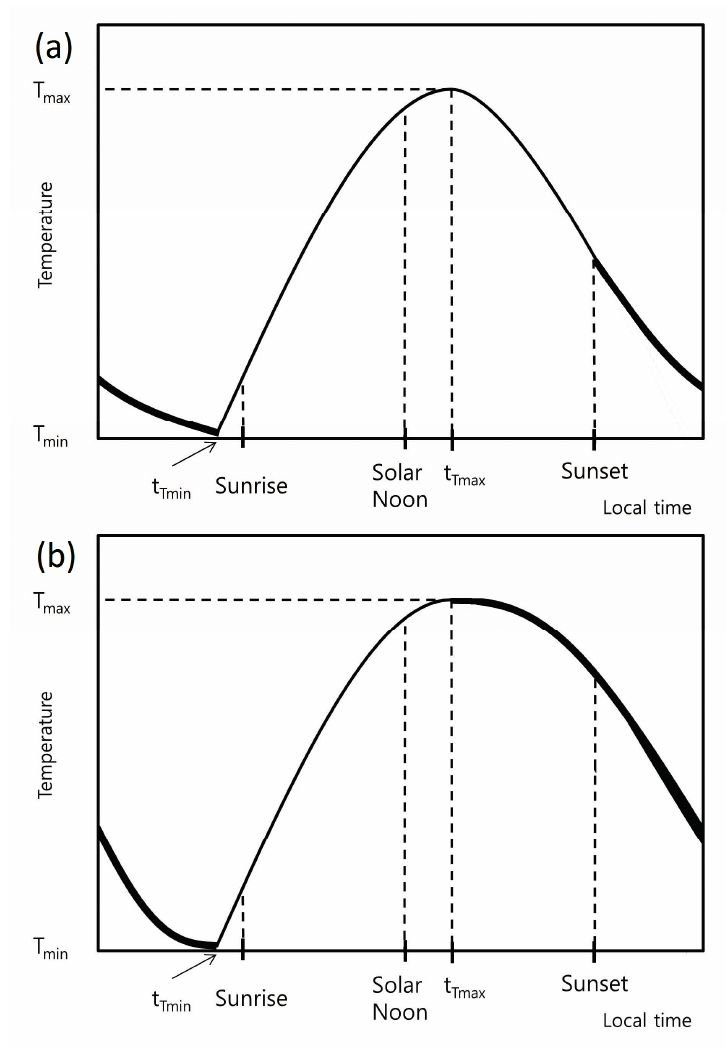
Figure 2. Diurnal temperature change models ( a ) using a sinusoidal (thin-line) and exponential (thick-line) functions for daytime and nighttime air temperature, respectively; and ( b ) using two sinusoidal functions for ascending (thin-line) and descending (thick-line) air temperature. T is for Temperature, and t is for local